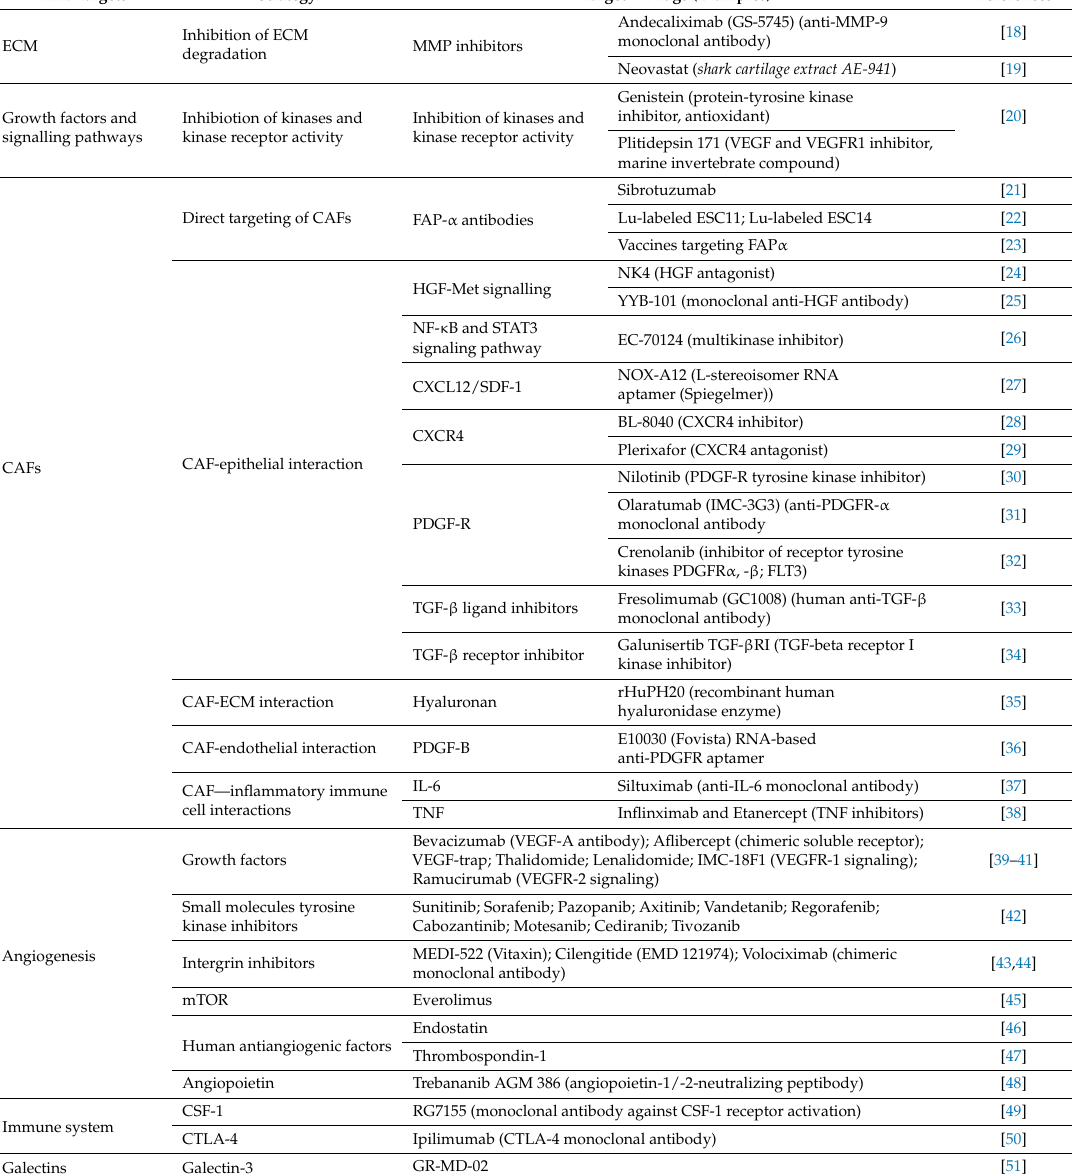
Table 2. Overview of currently tested drugs modulating the Tumor Microenvironment